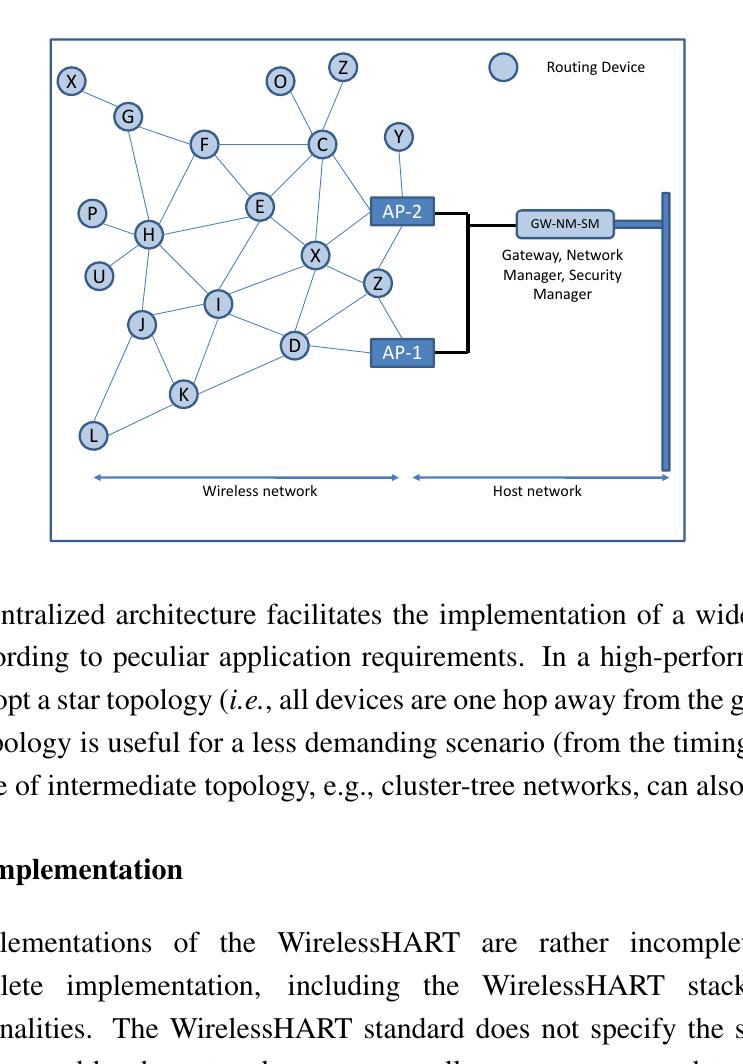
Figure 4. A sample WirelessHART (HART (Highway Addressable Remote Transducer)) network topology. AP : access